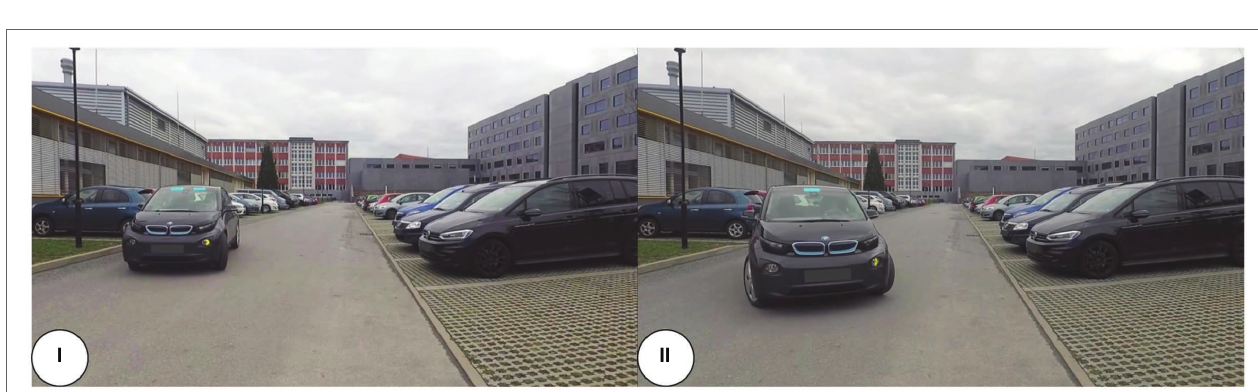
FIGURE 2 | Screenshot of the applied video material displaying the encountering interaction vehicle driving straight ahead the parking lot with the augmented light- based eHMI (signal: automation mode) from the pedestrians’ perspective standing in front of an empty parking space the participants were instructed intending to cross.